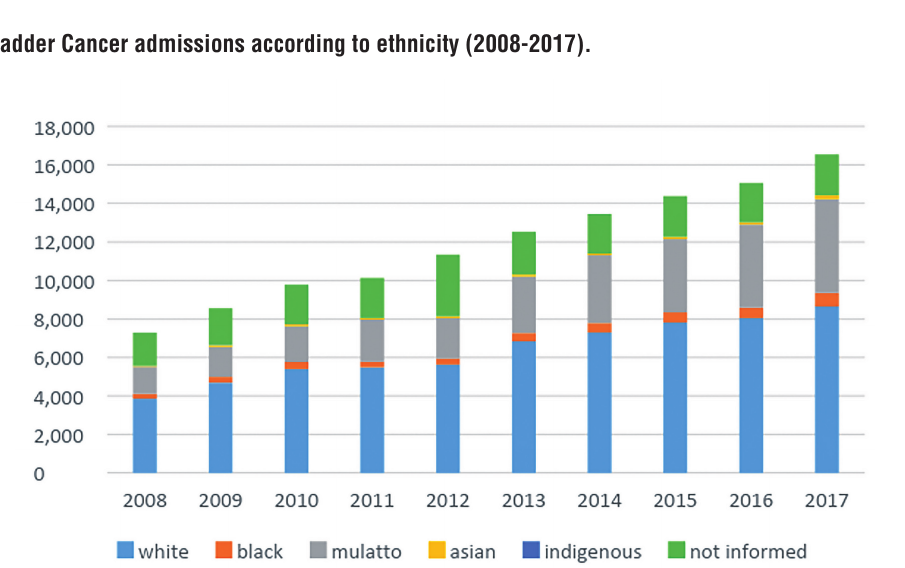
Figure 4 - Bladder Cancer admissions according to ethnicity